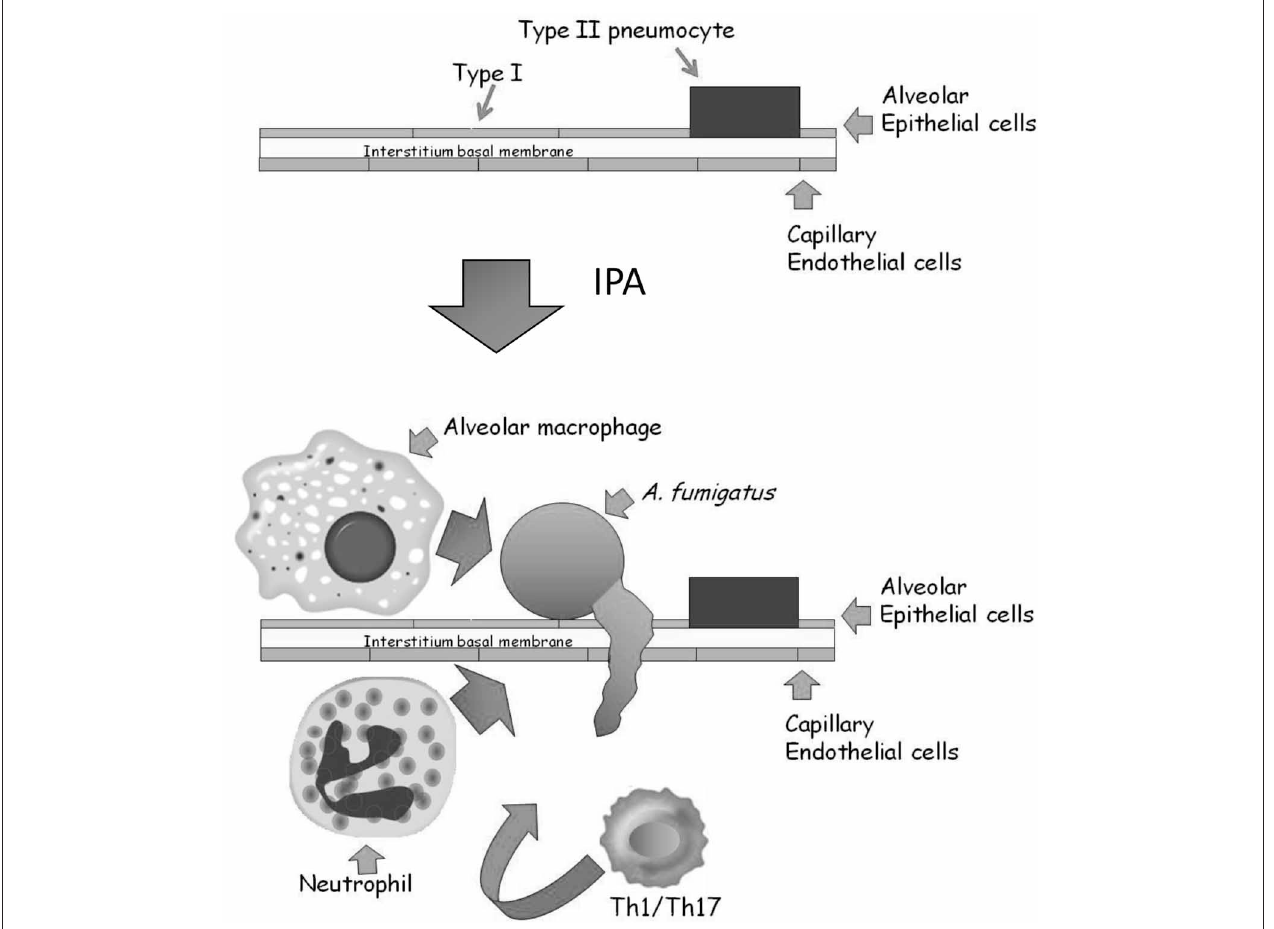
FIGURE 2 | Structure of the alveolus and the development of IPA. The major epithelial cell types of the alveolus are the type I and type II pneumocytes. They are attached to a thin basal membrane composed of laminin, collagen, and fibronectin. A single layer of capillary endothelial cells is attached to the lower side of the basal membrane, lining the blood vessel. In IPA, inhaled conidia germinate on the alveolar surface.